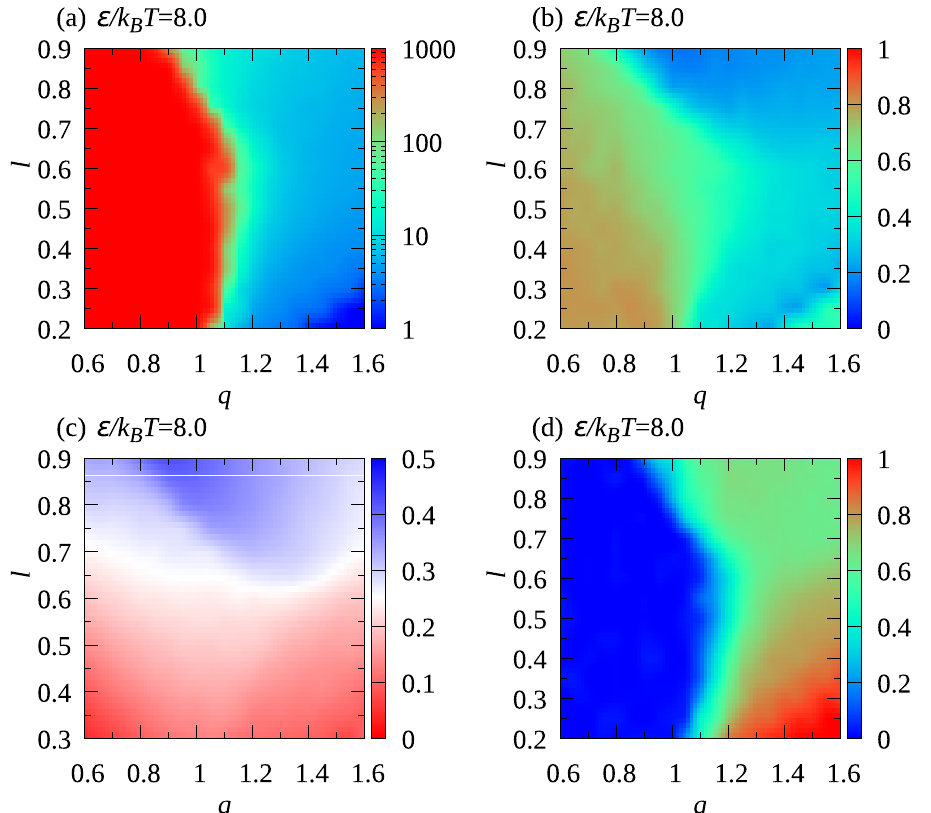
8.0 . ( e ) Top and ( f ) side views, =